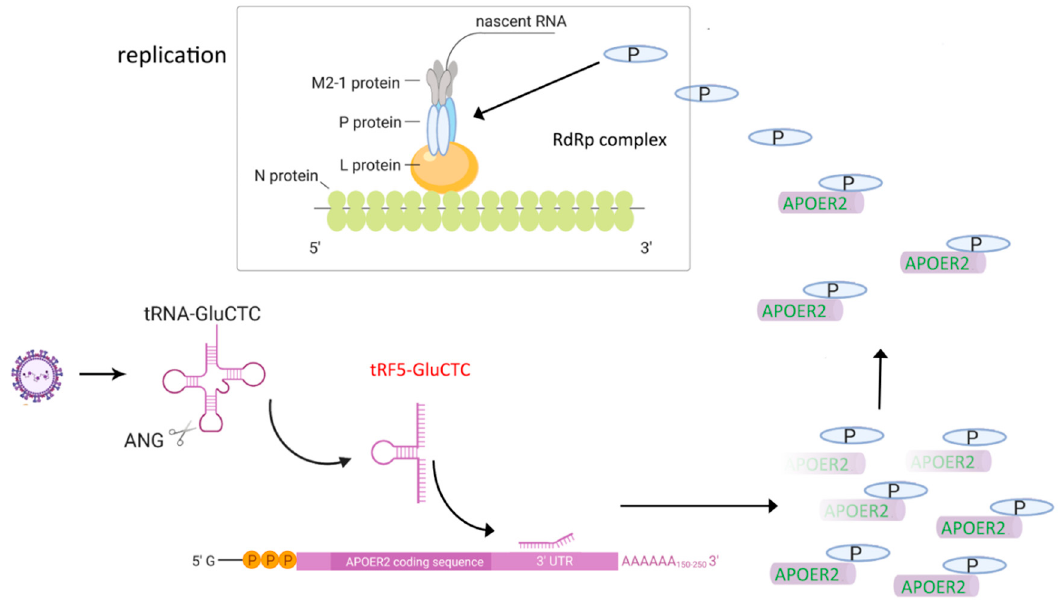
Figure 4. Model on the molecular mechanism used by tRF5-GluCTC to promote RSV replication. RSV infection induces tRF5-GluCTC, which targets APOER2 and suppresses its expression. APOER2 is an antiviral protein carrying out its antiviral role via its sequestration of the P protein of RSV. Therefore, the decreased expression of APOER2 frees more P proteins and makes them more available to form RdRp with other viral proteins.